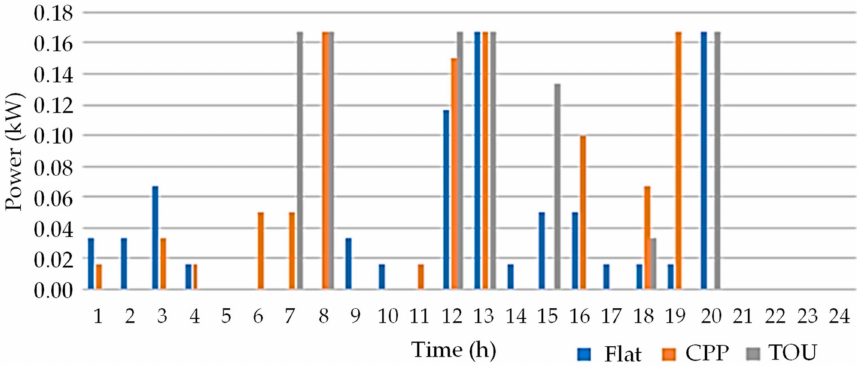
Figure 15. Energy consumed by the sanitarian water heater: Comparison between tari ff s